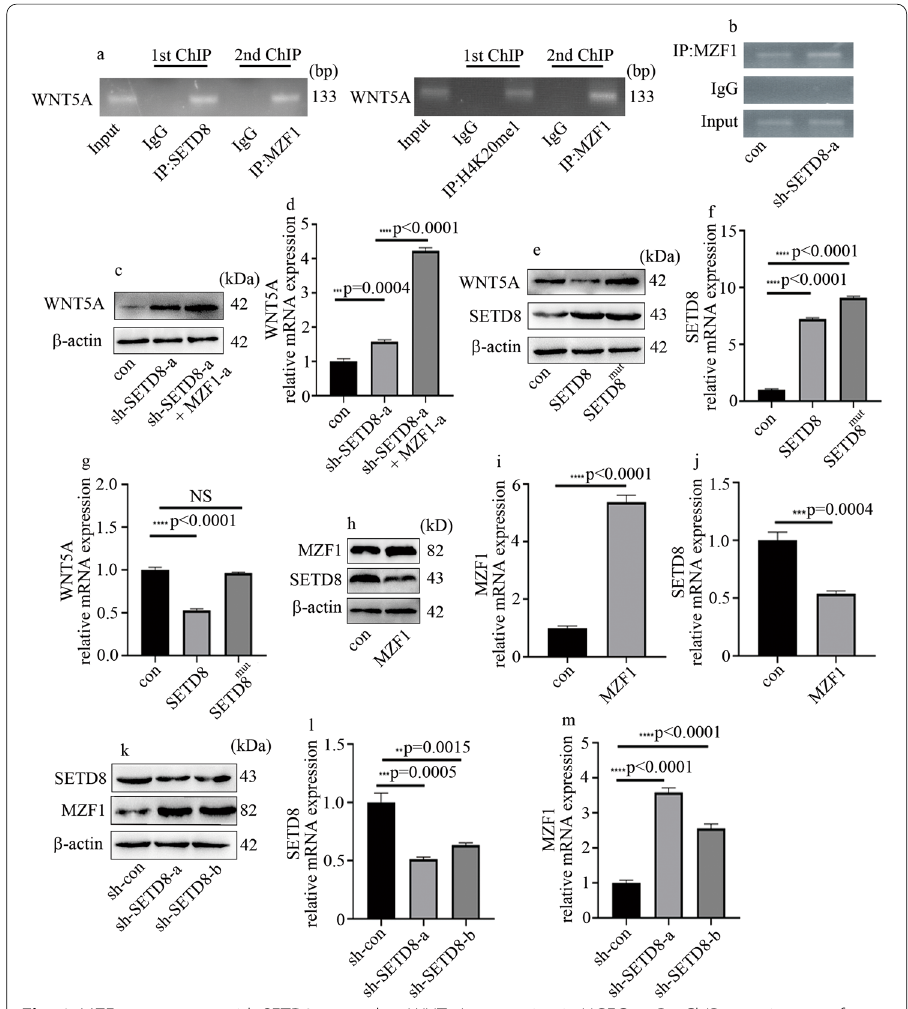
of WNT5A in HGECs. d mRNA expression of WNT5A in HGECs. e – g Protein and mRNA levels of SETD8 and WNT5A in HGECs. h – j Protein and mRNA levels of SETD8 and MZF1 in HGECs. k – m Protein and mRNA levels of MZF1 and SETD8 in HGECs (* p < 0.05, ** p < 0.01, *** p < 0.001, **** p < 0.0001, n